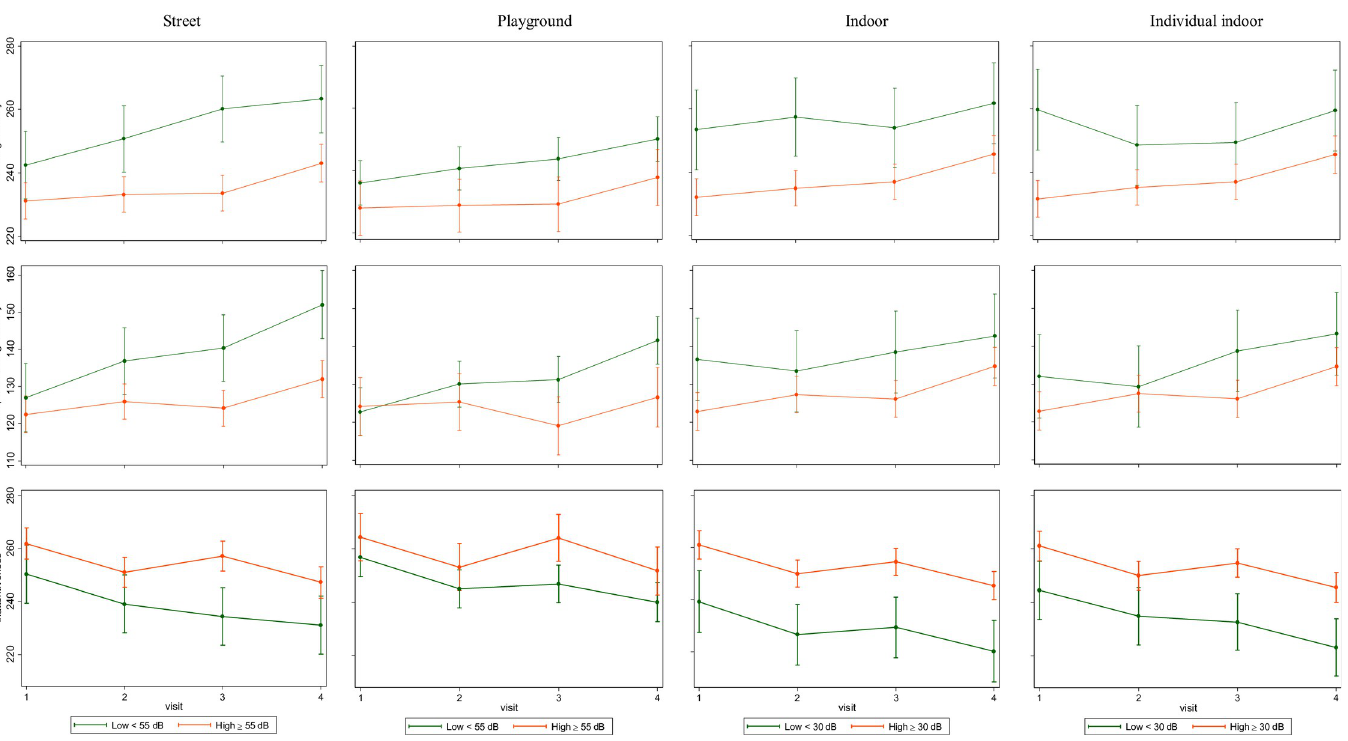
Fig 1. Annual trajectories of working memory, complex working memory, and inattentiveness in children attending schools with low and high average road traffic noise levels (LAeq, dB) outdoors in street and playground or indoors in 1 classroom (indoor level) or in each child’s classroom considering change of room between years (individual indoor level). Y axis: point estimate (beta coefficient), error bars (95% confidence intervals). Predictions for working memory (2-back number stimuli, d 0 ), complex working memory (3-back number stimuli, d 0 ), and inattentiveness (HRT-SE, ms) adjusted at the means of age, sex, corresponding road traffic noise indicator, age � road traffic noise indicator, maternal education, socioeconomical vulnerability index at home and outdoor or indoor TRAP at school for models including outdoor or indoor noise levels, respectively. Child and school included as nested random effects. d 0 : detectability, a higher value indicates better working memory; HRT-SE: hit reaction time standard error, a higher value indicates greater inattentiveness; LAeq: A-weighted equivalent noise levels; TRAP: traffic-related air pollution.